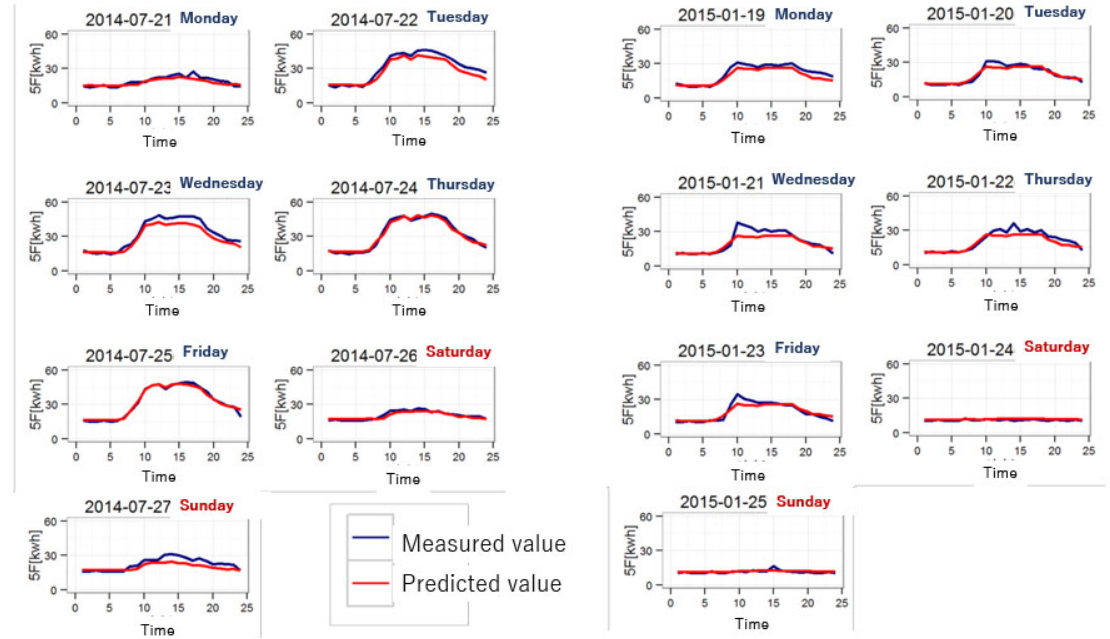
Figure 14. The results of the prediction by the EP tool for 5th floor in summer and winter